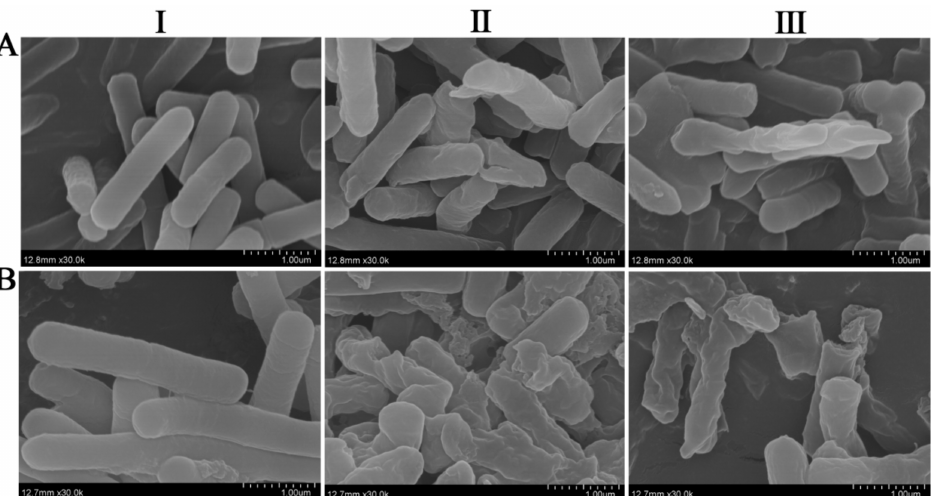
Figure 12. Effects of antimicrobial peptides CgR2150 and CgR3101 on cell membrane damage of X. oryzae pv. oryzae and C. michiganensis after treatment at MIC concentrations. ( A-I ) PBS, ( A-II ) CgR2150, and ( A-III ) CgR3101 acting on the cell membrane of X. oryzae pv. oryzae. ( B-I ) PBS, ( B-II ) CgR2150, and ( B-III ) CgR3101 acting on the cell membrane of C. michiganensis